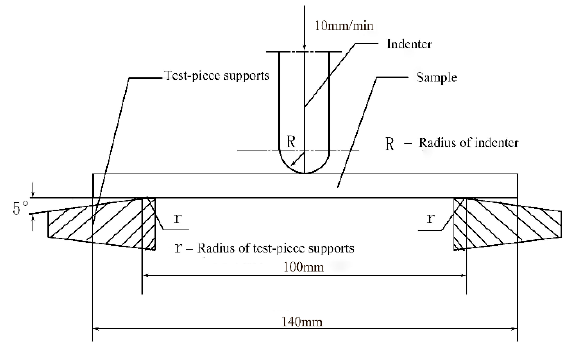
Figure 2. Schematic diagram of bending test.